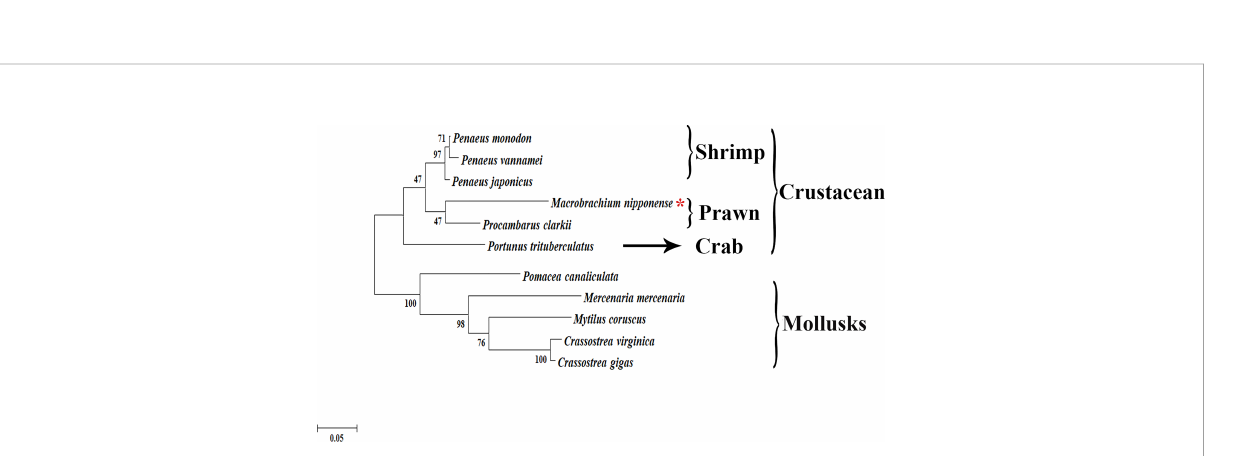
FIGURE 3 The phylogenetic tree of Plk1 from different organisms based on amino acid sequence comparisons. Species names of Plk1 are listed on the right of the tree. Red asterisk indicated M. nipponense